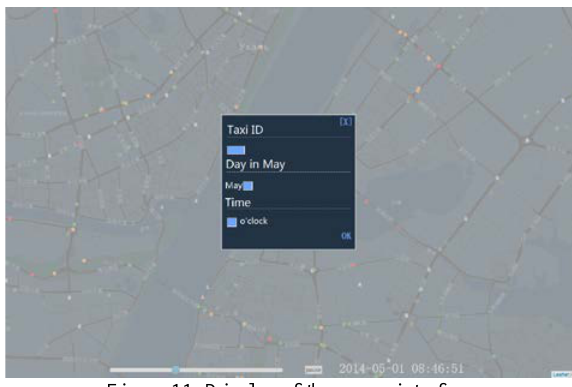
Figure 11. Display of the query interface.